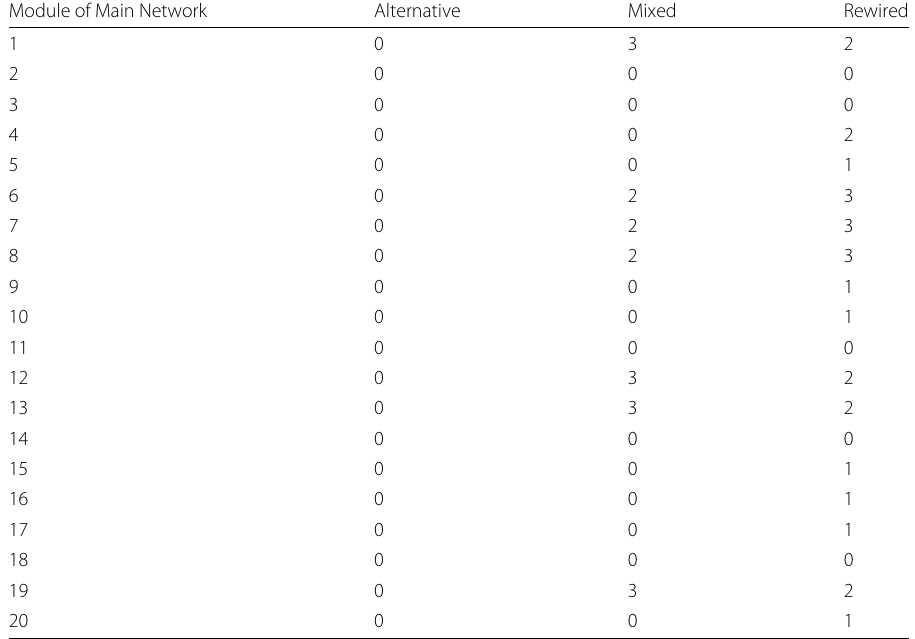
Table 9 Number of modules in networks that have Jaccard index J = 1 with a module of the Main network Module of Main Network Alternative Mixed